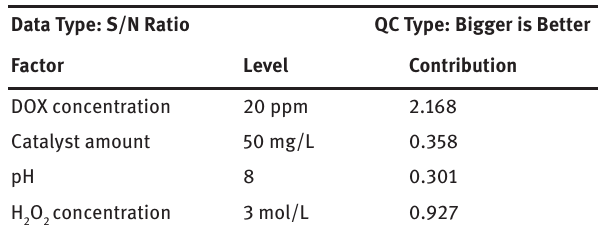
Figure 5: Effect of each parameter on S/N ratios in drug removal. (A) DOX concentration, (B) catalyst amount, (C) pH, (D) H